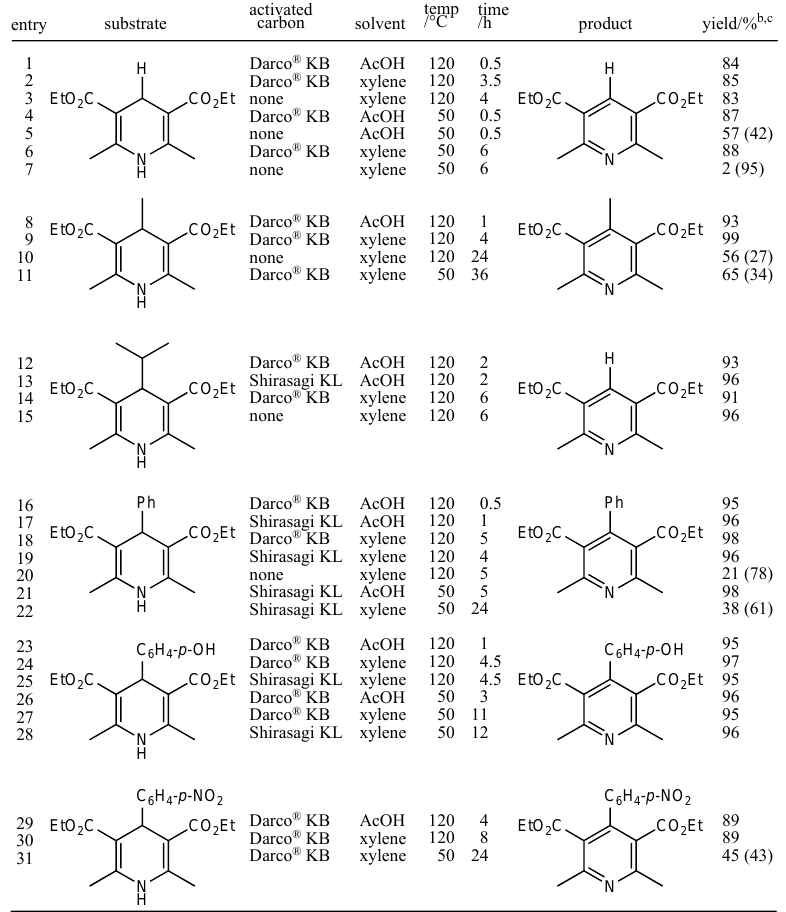
Table 2. Oxidative aromatization of Hantzsch 1,4-dihydropyridines with molecular oxygen promoted by activated carbon.